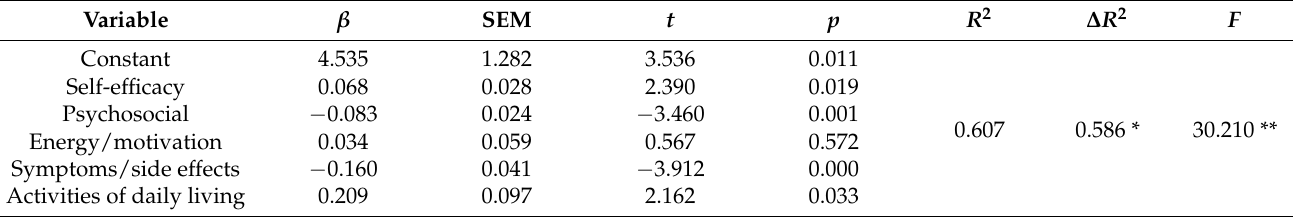
Table 3. Linear regression analysis of medication adherence of patients with